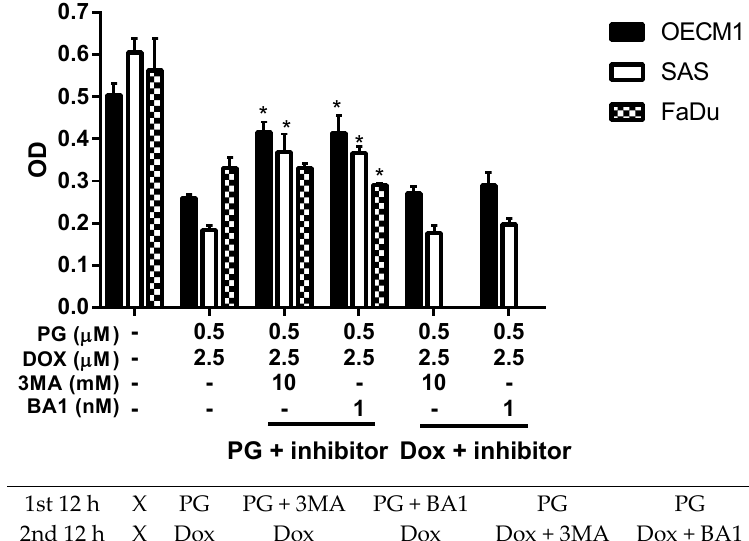
Figure 4. Alteration of cell viability combined with autophagy inhibitor. OSCC cells were treated with PG + inhibitor/DOX or PG/Dox + inhibitor and cell viability was analyzed. Table under figure was the scheme of treatment. “X” meant incubated with complete medium without PG or Dox. The results were represented as mean ± SD from three individual experiments. * p < 0.05 as compared with PG/Dox.